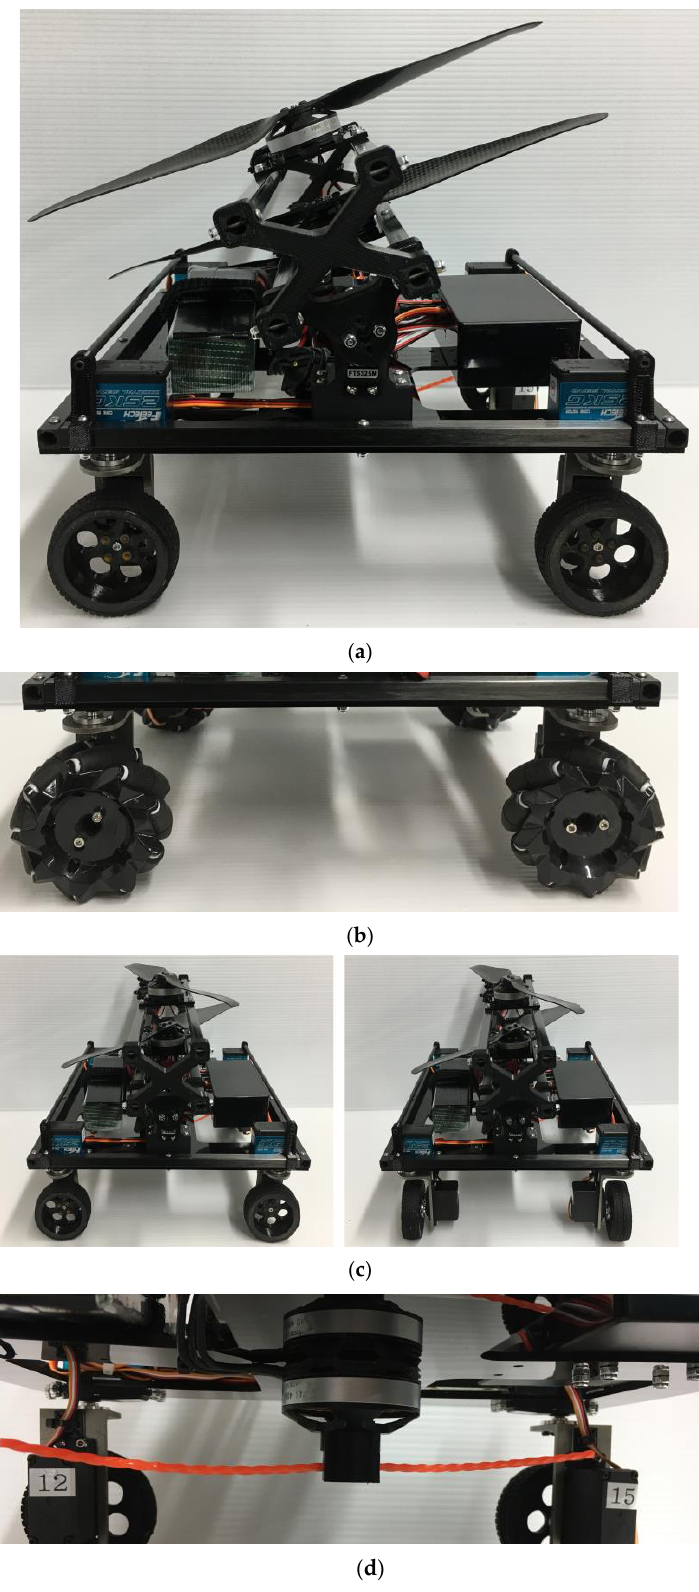
Figure 6. Completely developed robot. ( a ) Overview of the developed robot. ( b ) Mecanum wheel installation. ( c ) 90° rotation of the steering wheels (left: climbing mode; right: sideways mode). ( d ) Nylon cord grass cutting tool.